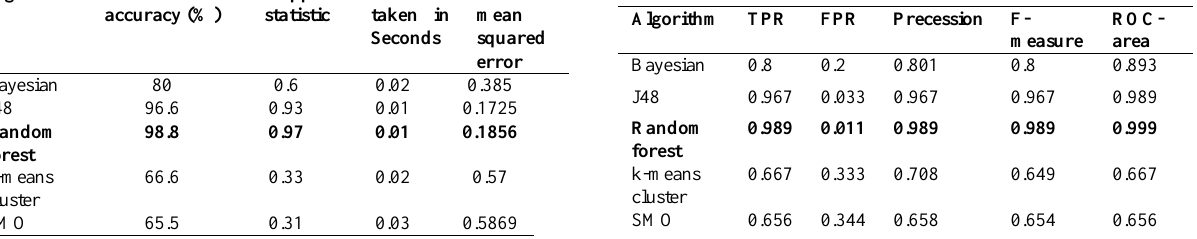
Table 7. Performance parameters measure (weighted average value) of different algorithms for core